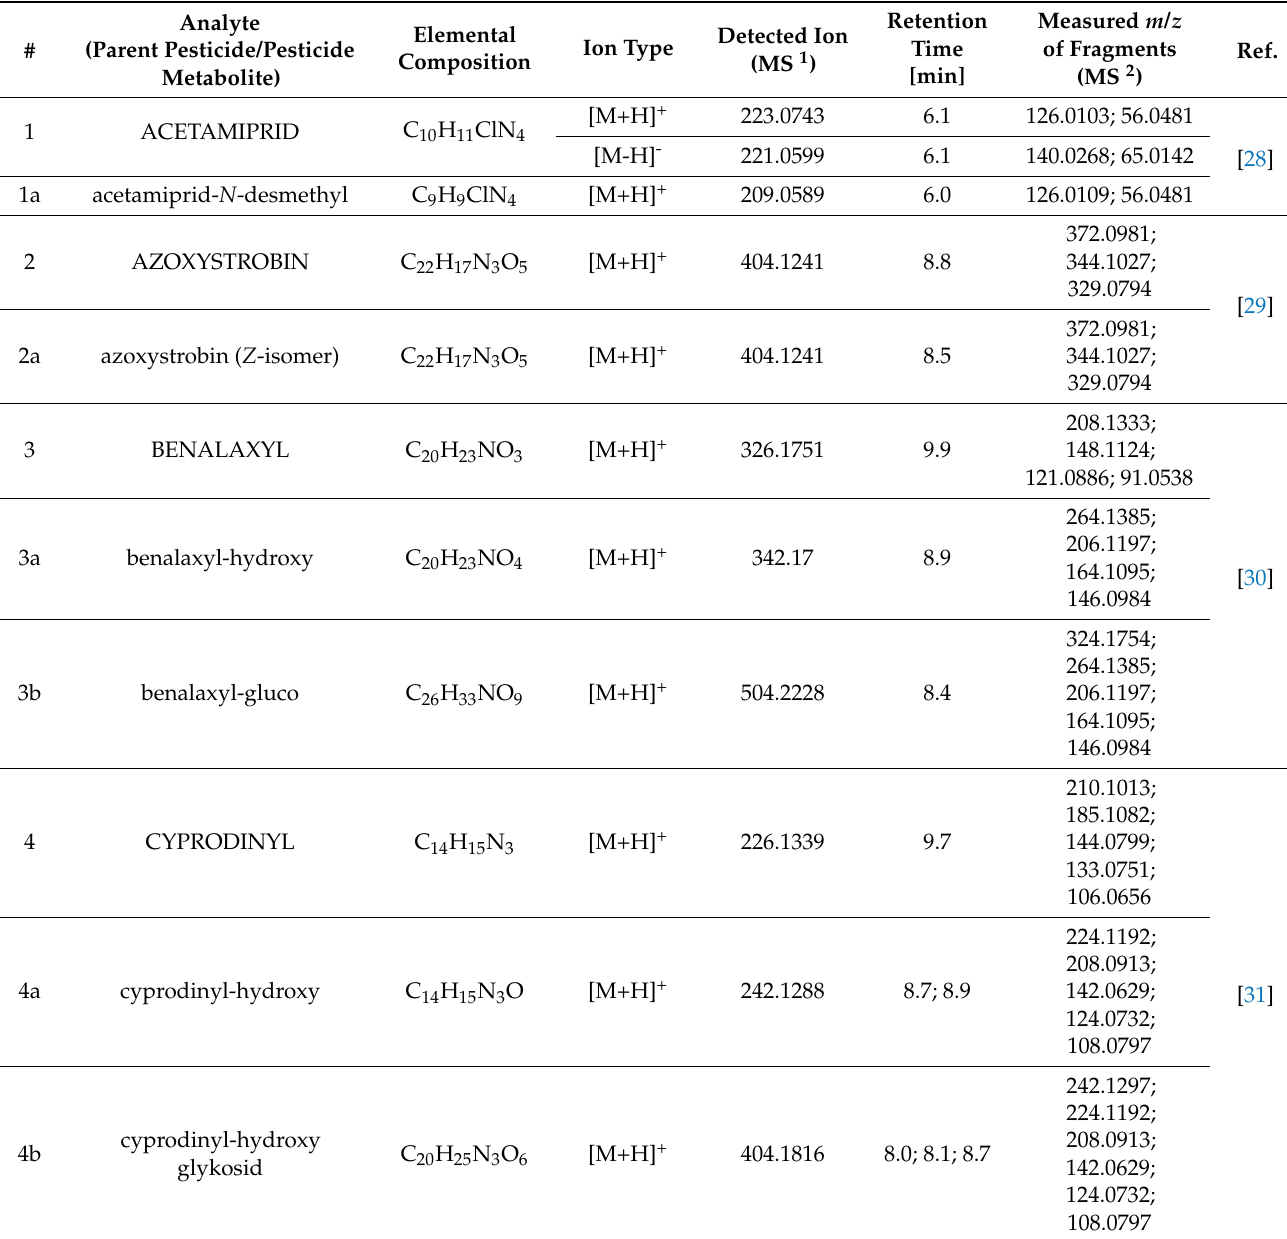
Table A1. The list of pesticide residues and their tentatively identified